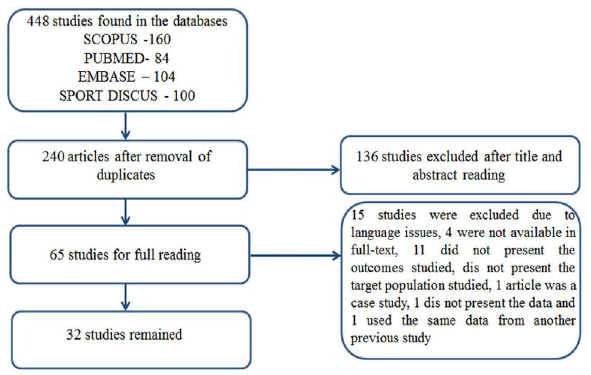
Figure 1 - Flowchart of search and analysis of articles in the different review phases.